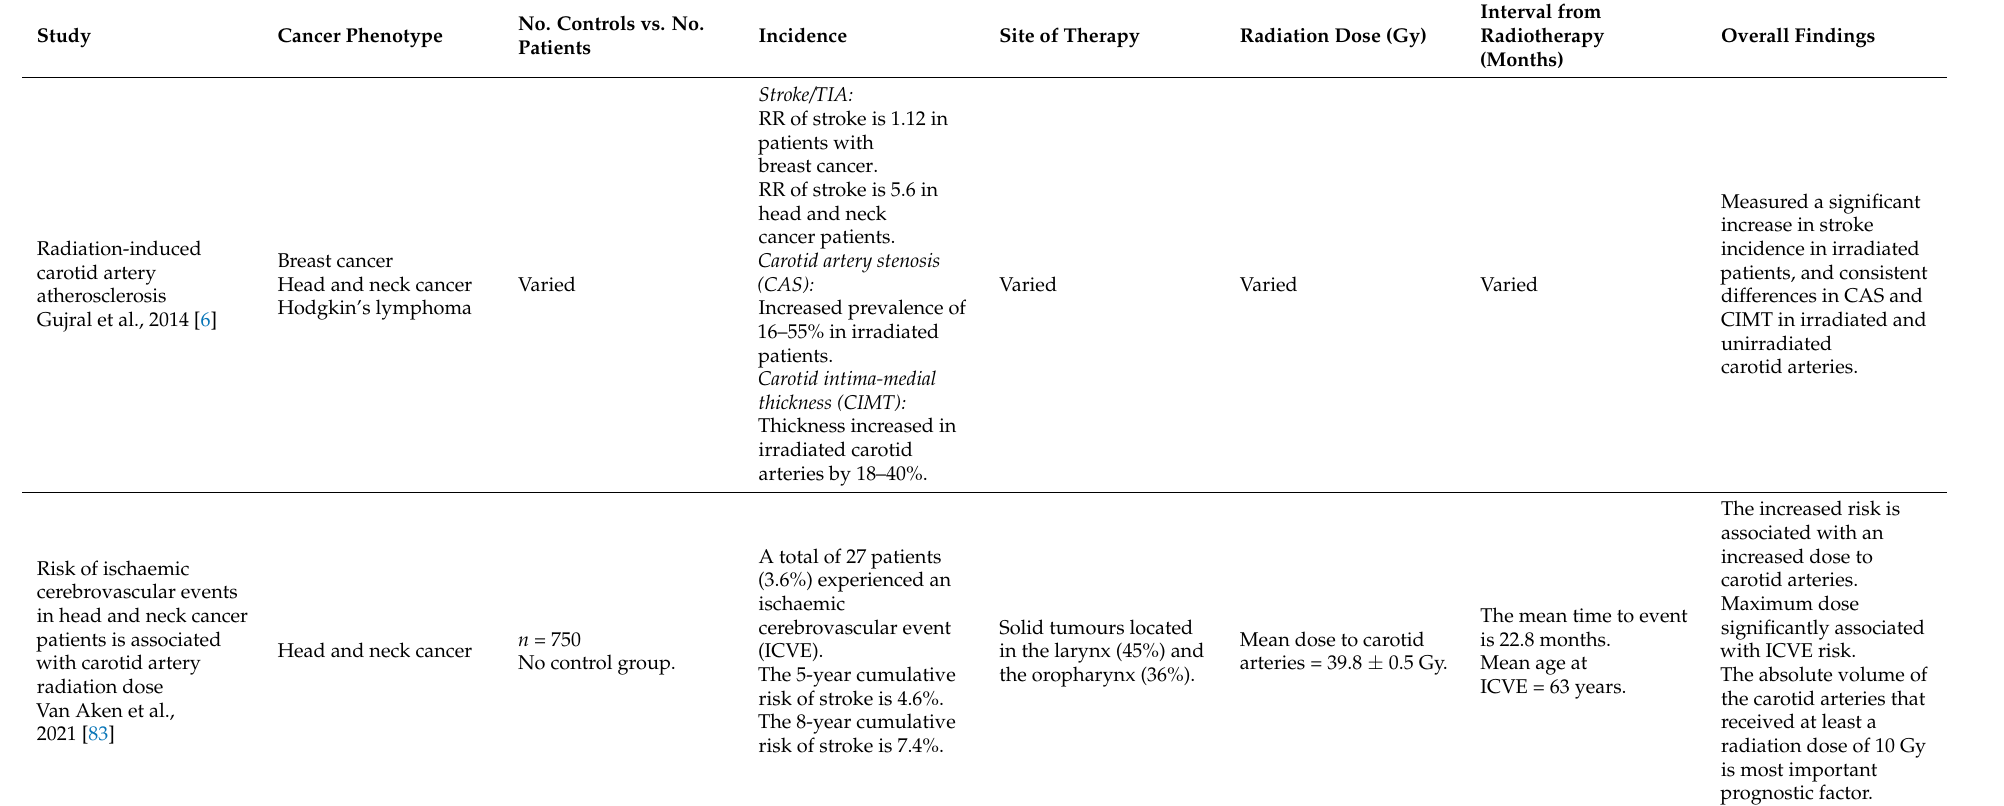
Table 2. Radiotherapy and atherosclerotic and thromboembolic outcomes in cancer